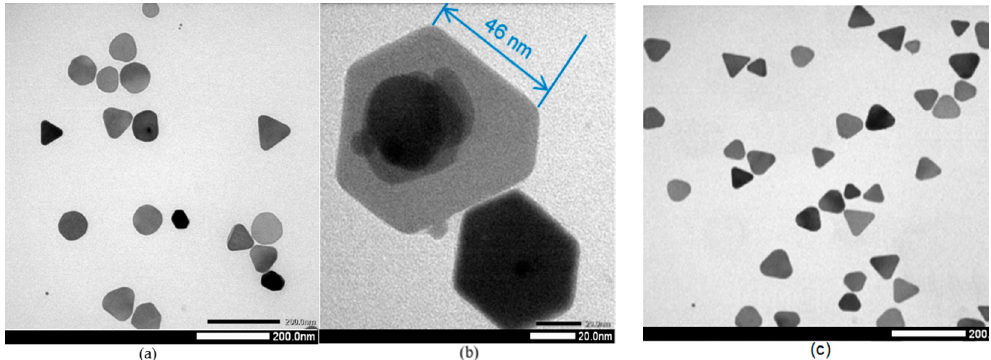
Figure 2. TEM images of ( a ) the nanodisk shapes (scale 200 nm) (75 µ L AgNO 3 0.01 M); ( b ) the hexagonal shapes (scale 20 nm) (125 µ L AgNO 3 0.01 M); and ( c ) high yield of triangular shapes (80%) of silver nanoplates (200 µ L AgNO 3 0.01 M) (scale 200 nm).